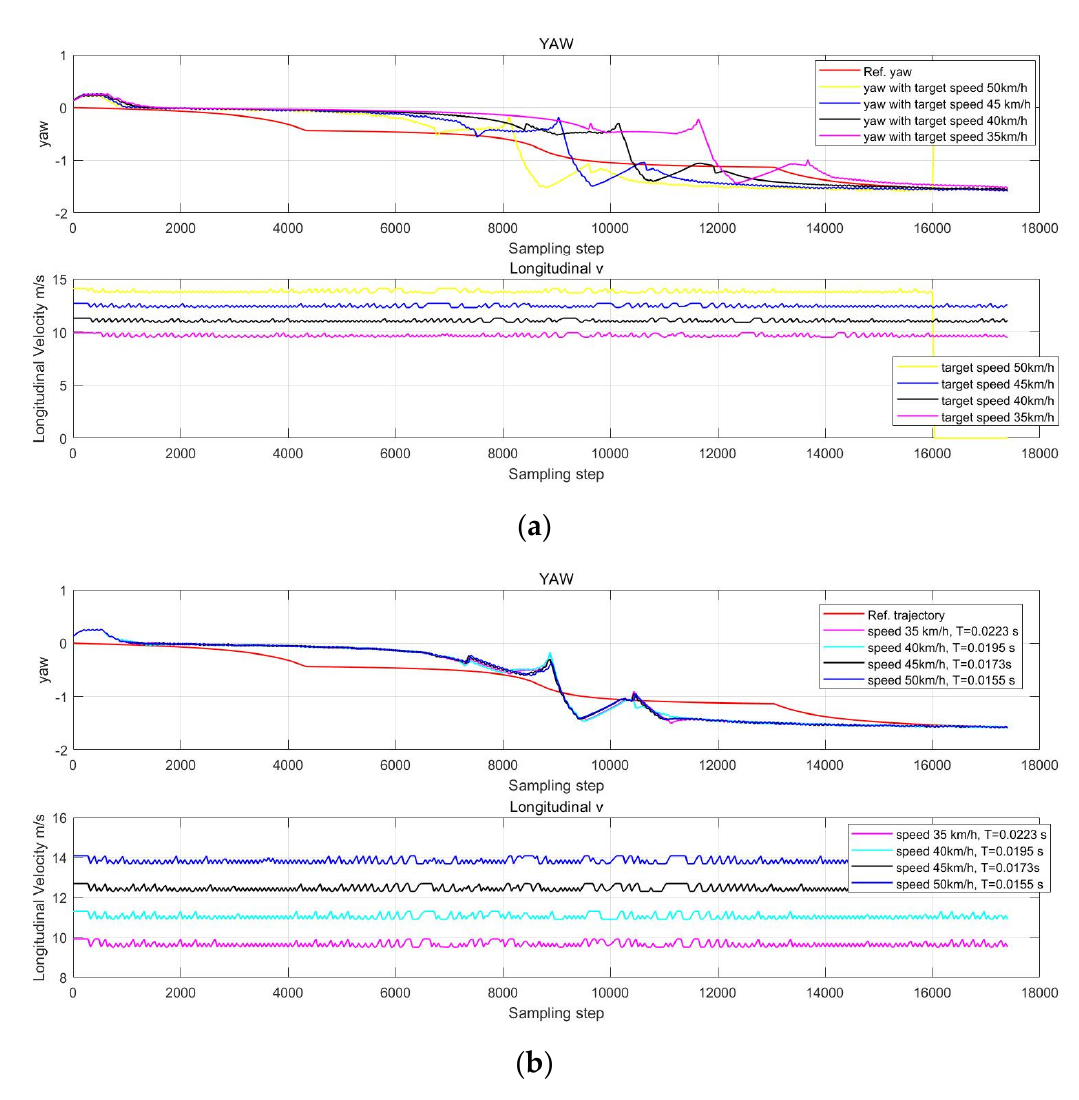
Figure 10. ( a ) Shows the comparison of yaw rate after changing the target speed. ( b ) Compares yaw rate after changing the target speed and the sample time T tuning condition.